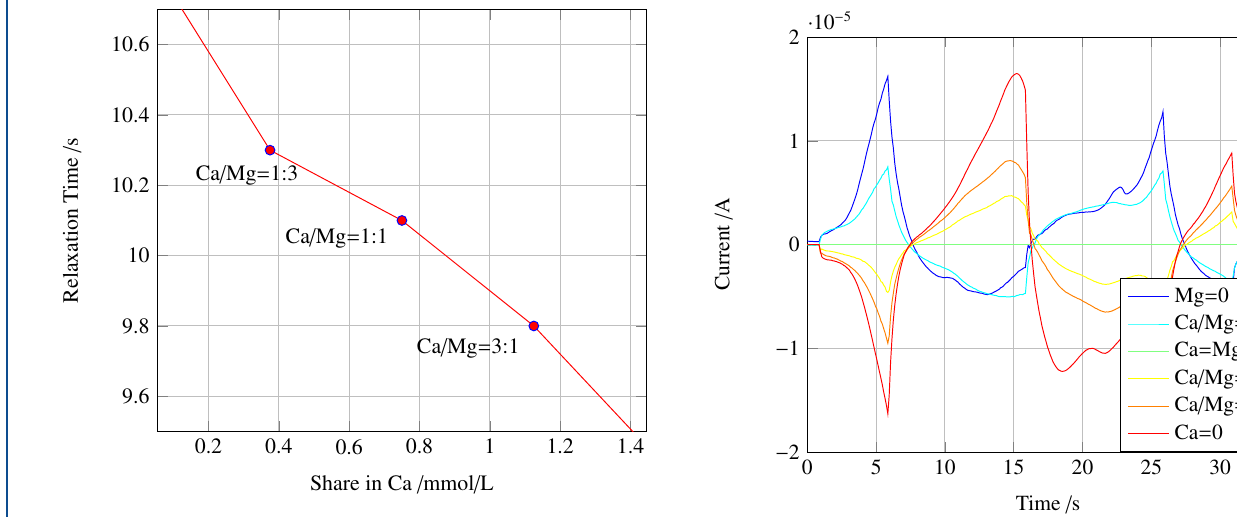
Figure 11. Relative current response of di ff erent Ca / Mg-ratios based on a balanced Ca / Mg-ratio.